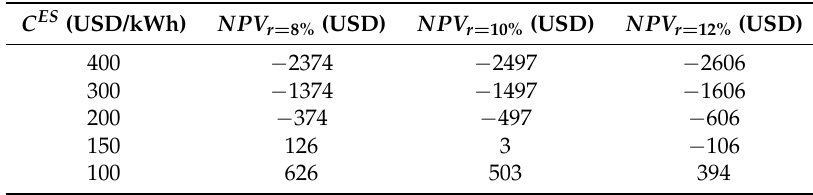
Table 2. Simple tariff net present values for different battery prices and